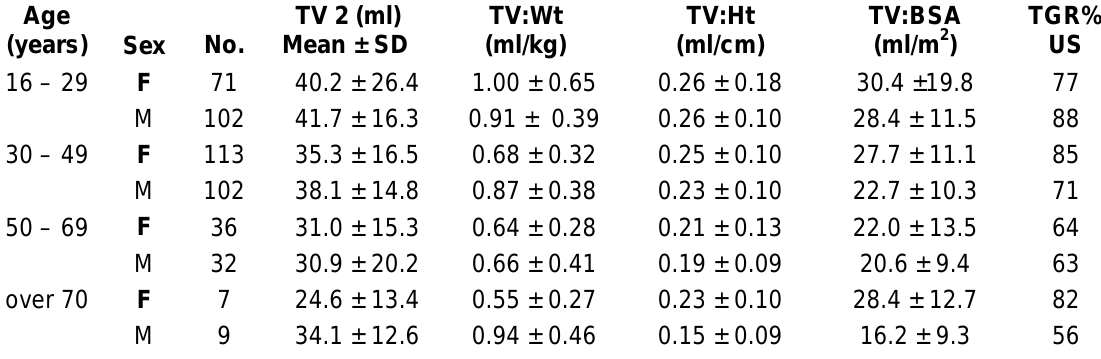
Age and Sex Distribution of Thyroid Volume (TV), Body Weight and Ratio of TV to Weight, Height, and